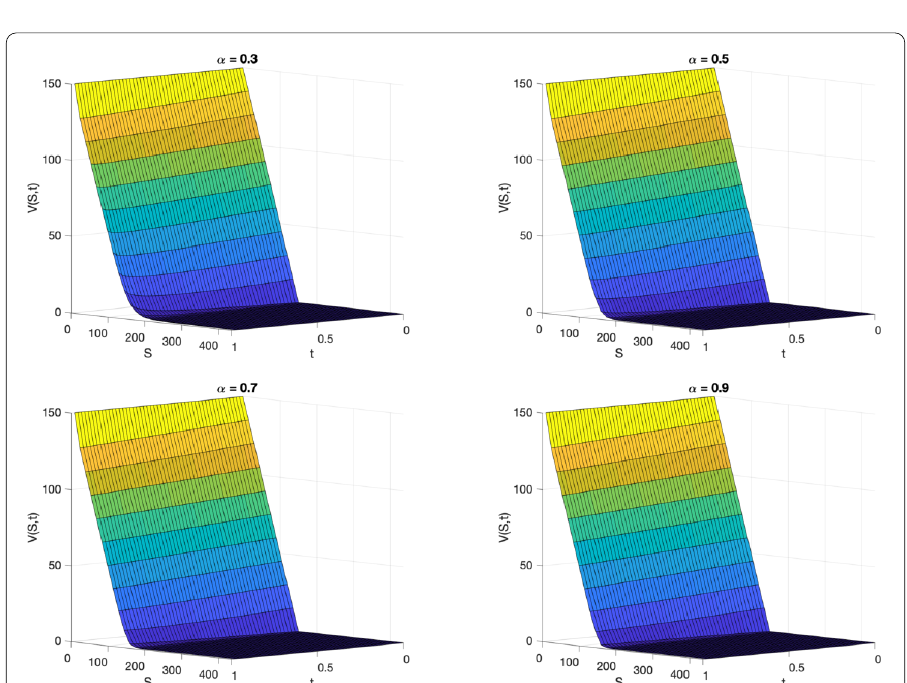
Figure 5 Payoffs under Example 5.1 for α = 0.3,0.5,0.7,0.9; δ = 0.045, for all 0 ≤ t ≤ T